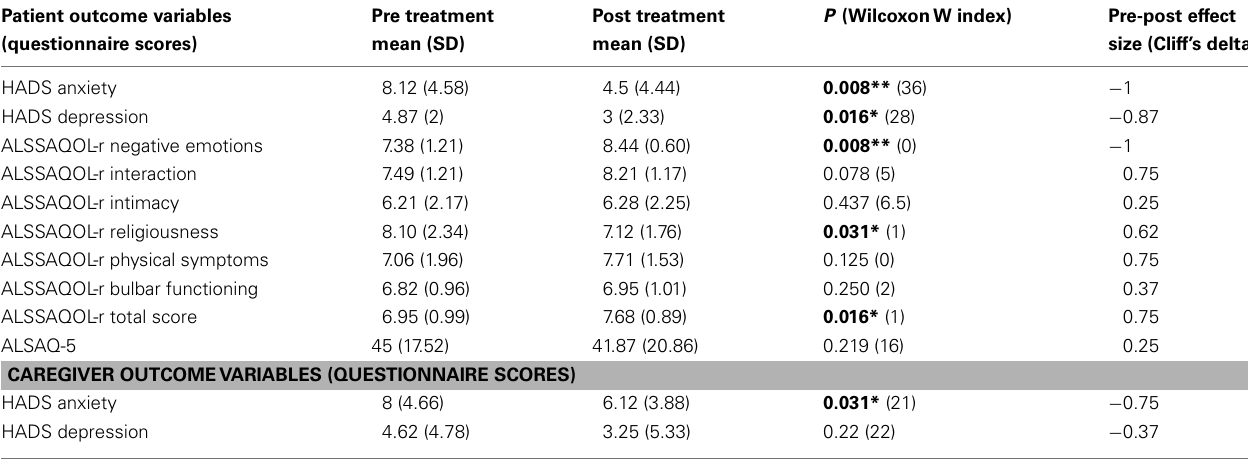
Table 2 | Patient pre and post treatment psychological